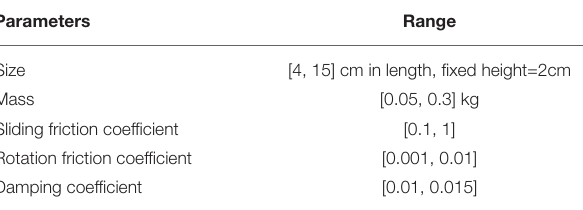
TABLE 2 | Dynamic parameters and their ranges in